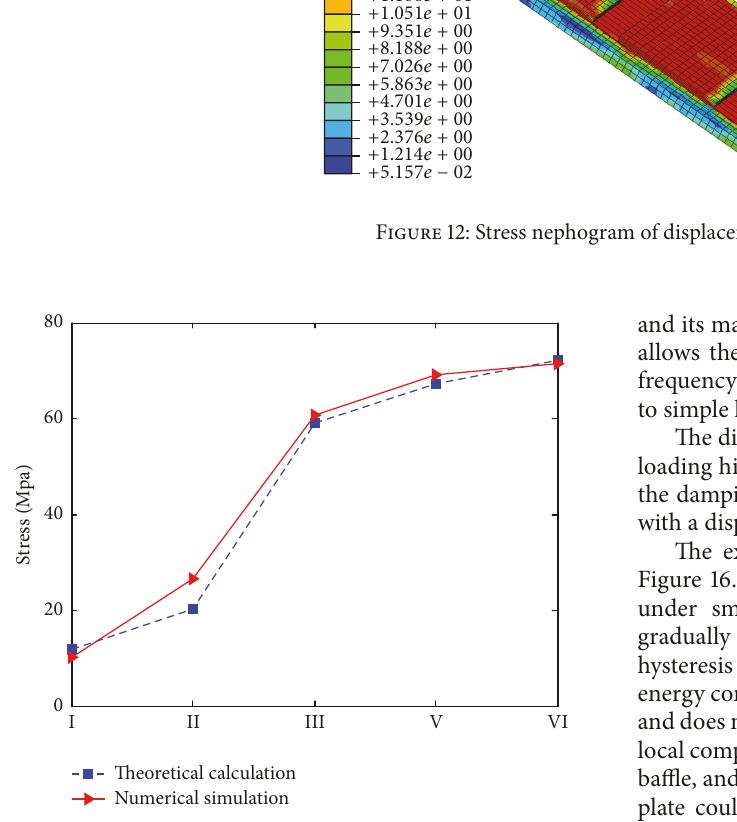
Figure 13: Comparison of theoretical and finite element solution of sectional normal